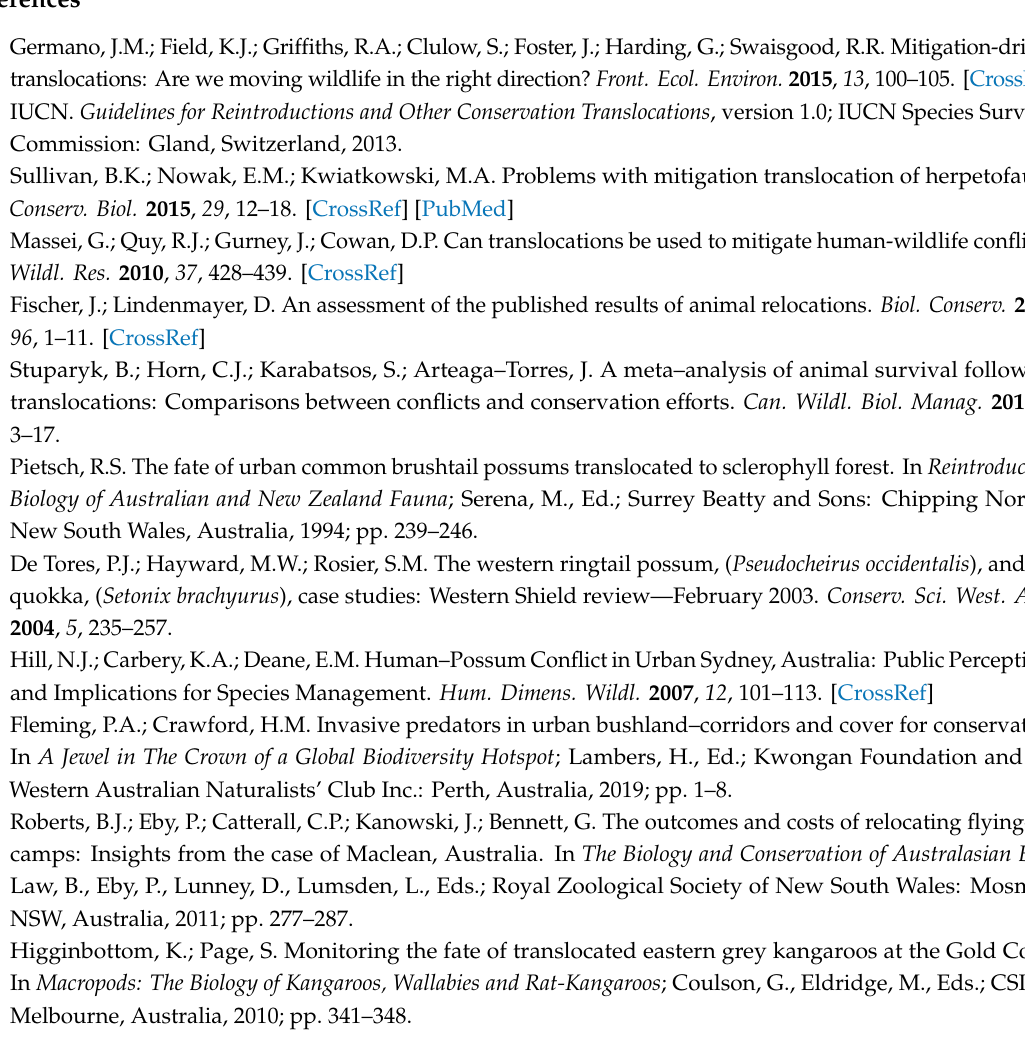
Figure A5. Movement of GPS collared western grey kangaroos (coloured circles) that died following relocation.